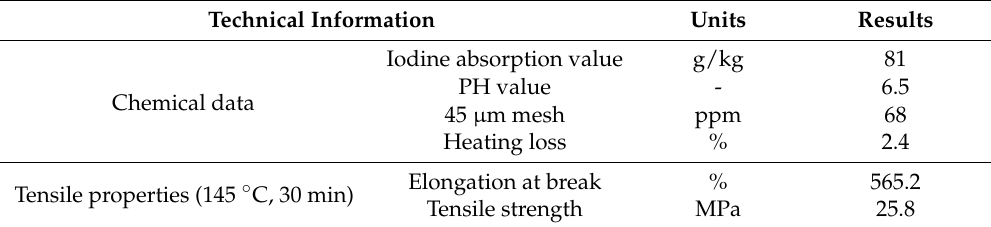
Table 2. Technical information on TPCB.